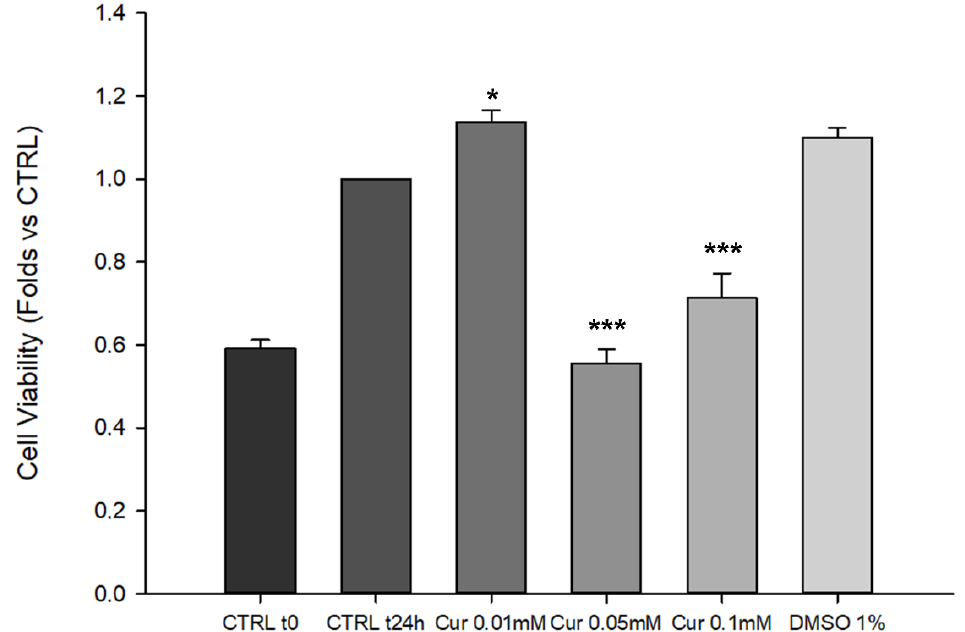
Figure 1. Cur effects on cell viability of ARPE-19 assessed by CCK-8 assay. Data are shown as mean ± SE. Statistical analysis was performed using one-way ANOVA test followed by the Holm-Sidak test. * p < 0.05; *** p < 0.001 versus CTRL t24 h (n = 3). The comparison between the treated groups and the baseline (CTRL t0) was carried out by calculating the mean differences.